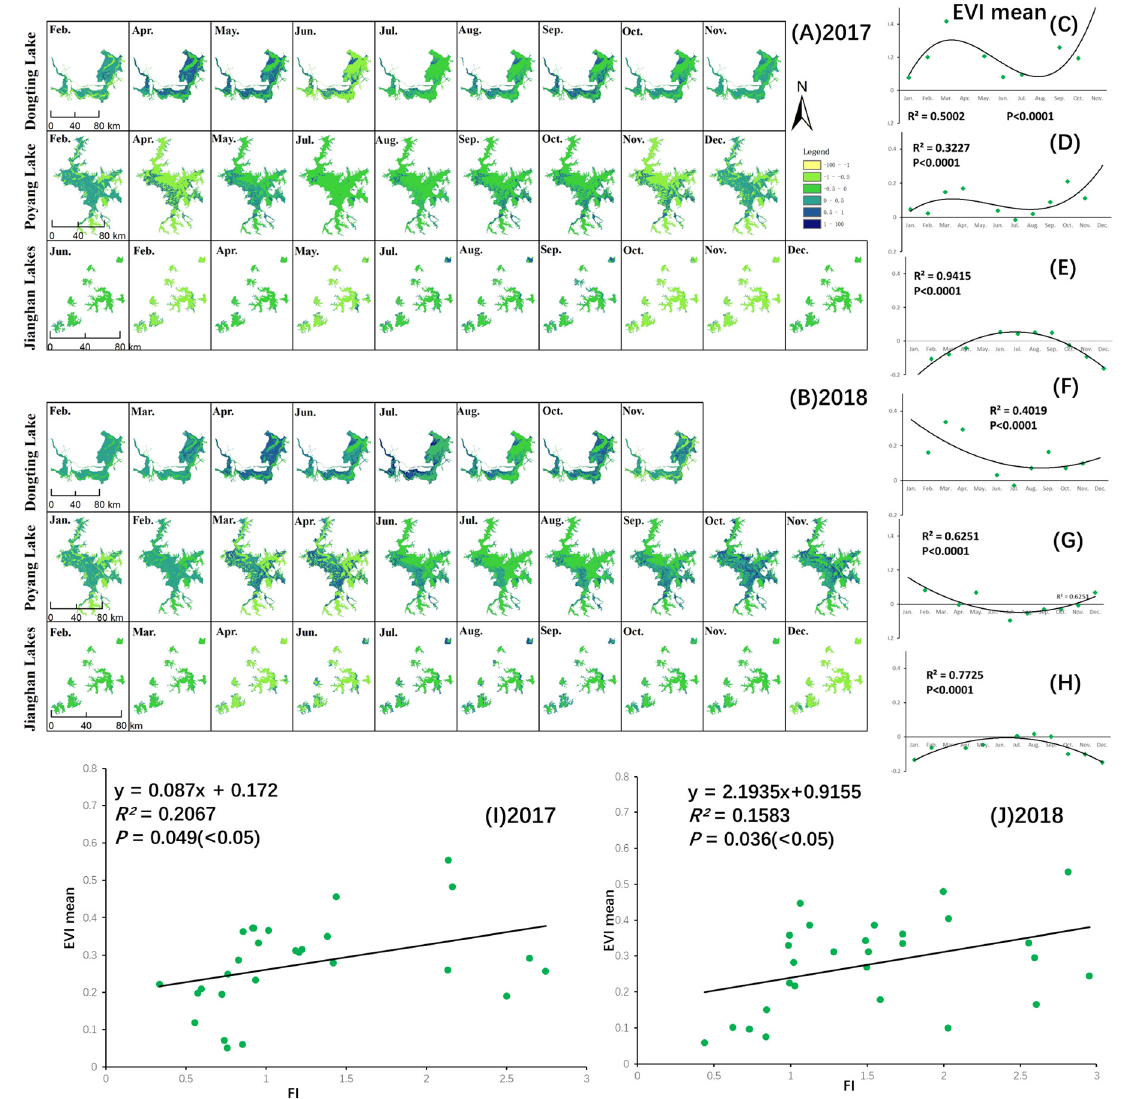
Figure 5. Annual variation of EVI for DT, PY, and JH in ( A ) 2017 and ( B ) 2018. The trend of mean EVI for ( C ) PY, ( D ) DT, and ( E ) JH in 2017. The trend of PD for ( F ) PY, ( G ) DT, and ( H ) JH in 2018. The relationships between the PD and mean EVI for DT, PY, and JH in 2017 ( I ) and 2018 ( J ).